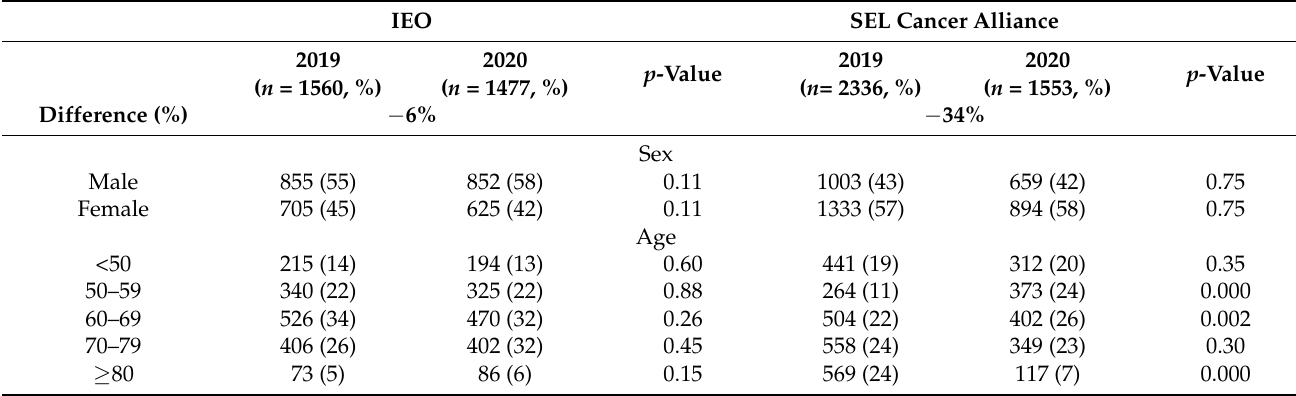
Table A1. Contains the patient characteristics of all cancer patients receiving radical surgery between 1 March